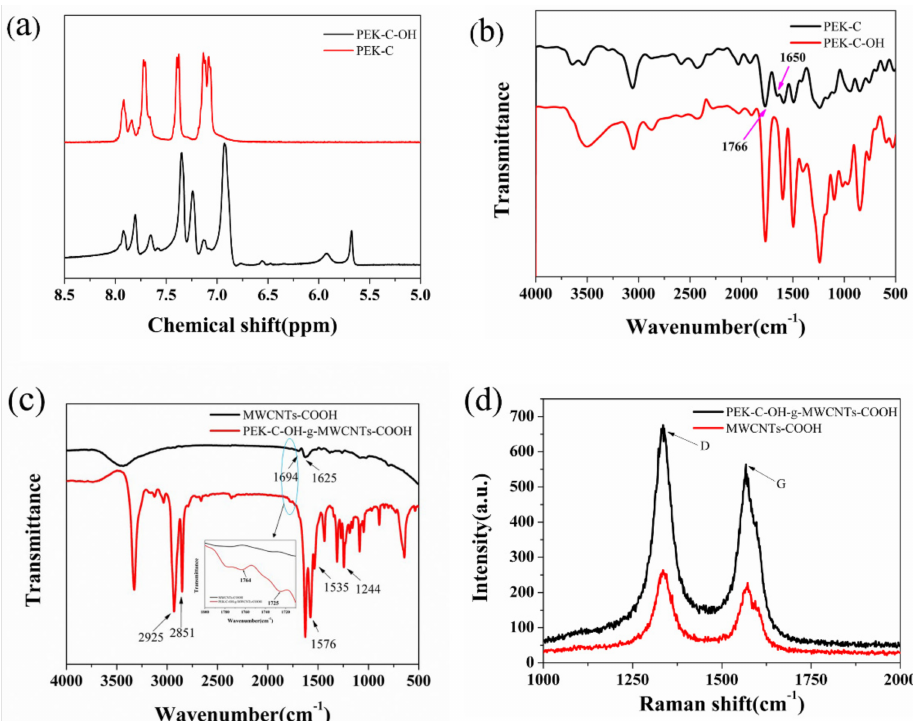
Figure 2. ( a ) 1 H NMR spectra of PEK-C and PEK-C-OH; ( b ) Infrared spectra of PEK-C and PEK-C- OH; ( c ) Infrared spectra of MWCNTs-COOH and PEK-C-OH-g-MWCNTs-COOH; ( d ) Raman spectra of MWCNTs-COOH and